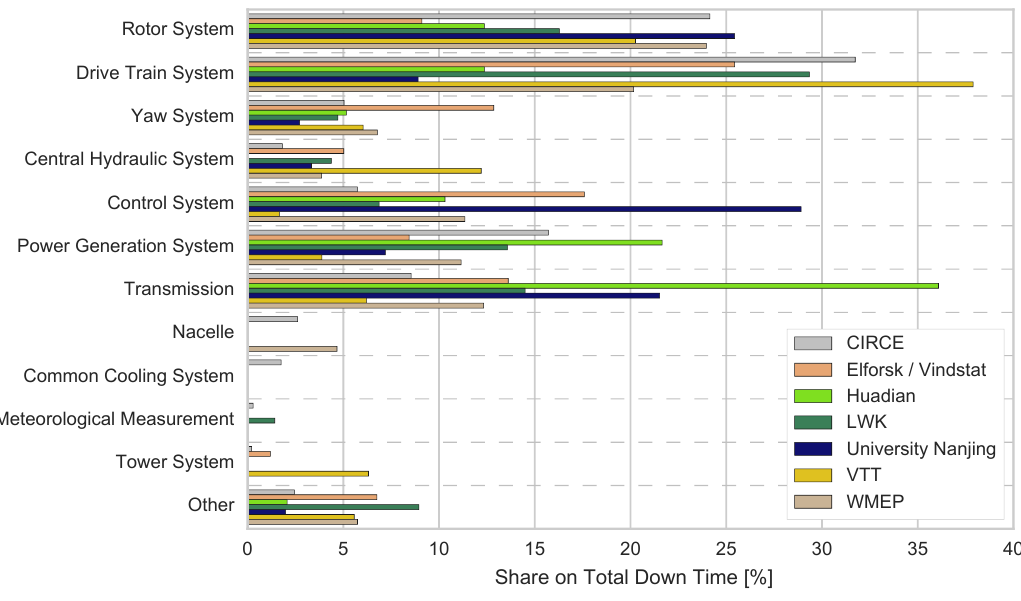
Figure 8. Share on total down time per system of onshore WT as published by different